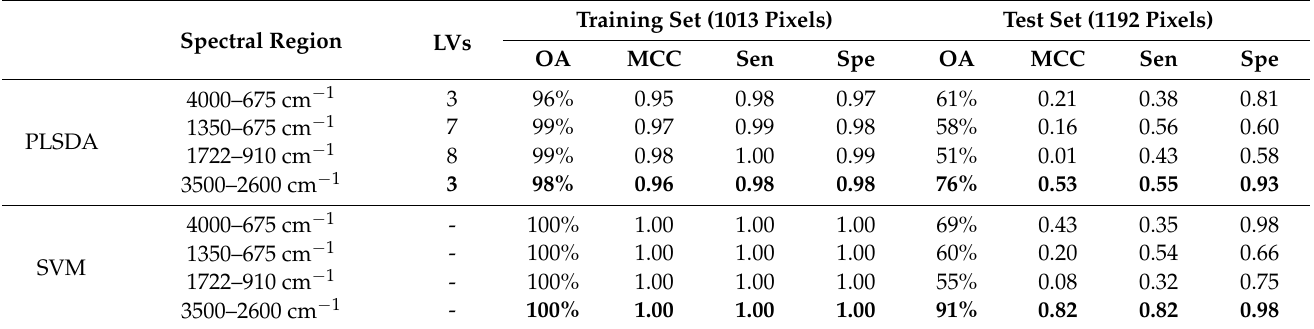
Table 5. Model performance to compare classifiers (PLSDA against SVM) and different spectral regions for samples deposited on the aluminium substrate. Training Set (1013 Pixels) Test Set (1192 Pixels) Spectral Region LVs OA MCC Sen